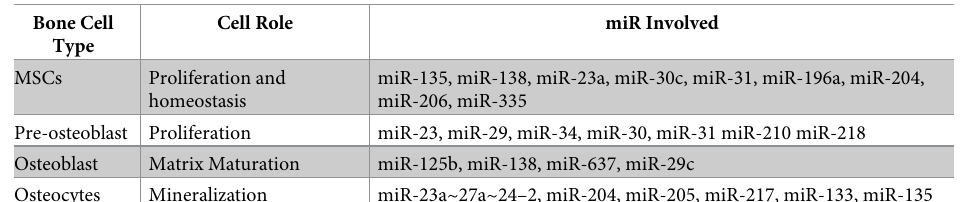
Table 1. The role of miRs in several bone cell